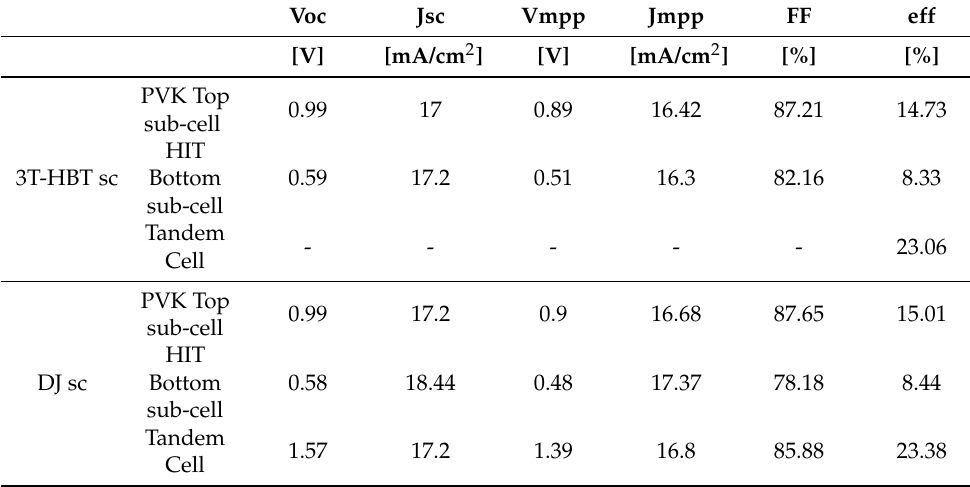
Table 2. 3T-HBT and DJ solar cells: Figures of